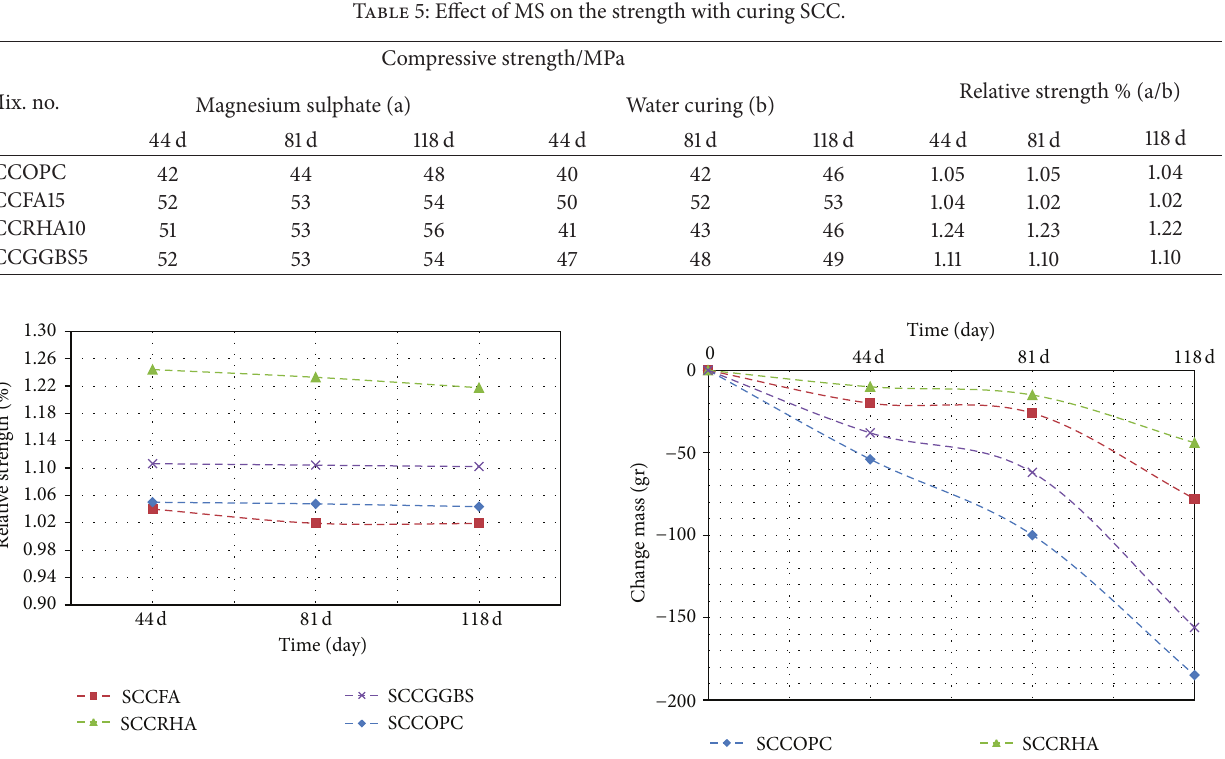
Figure 2: Effect of MS on the strength with curing water SCC.